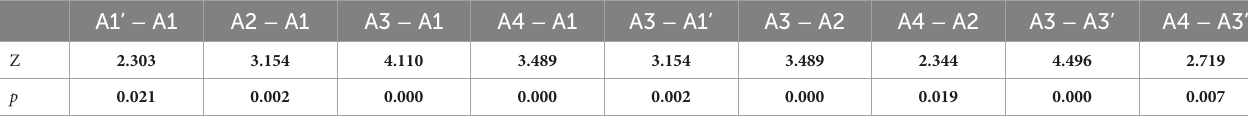
TABLE 7 Wilcoxon ranked sign test for the searching time (only for p < 0.05).